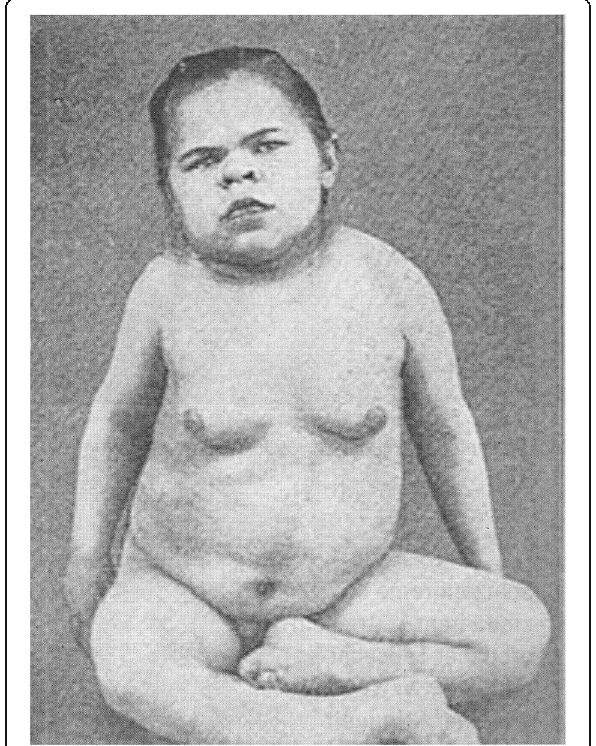
Fig. 5 Patient with severe myxedema by congenital hypothyreoidism (from